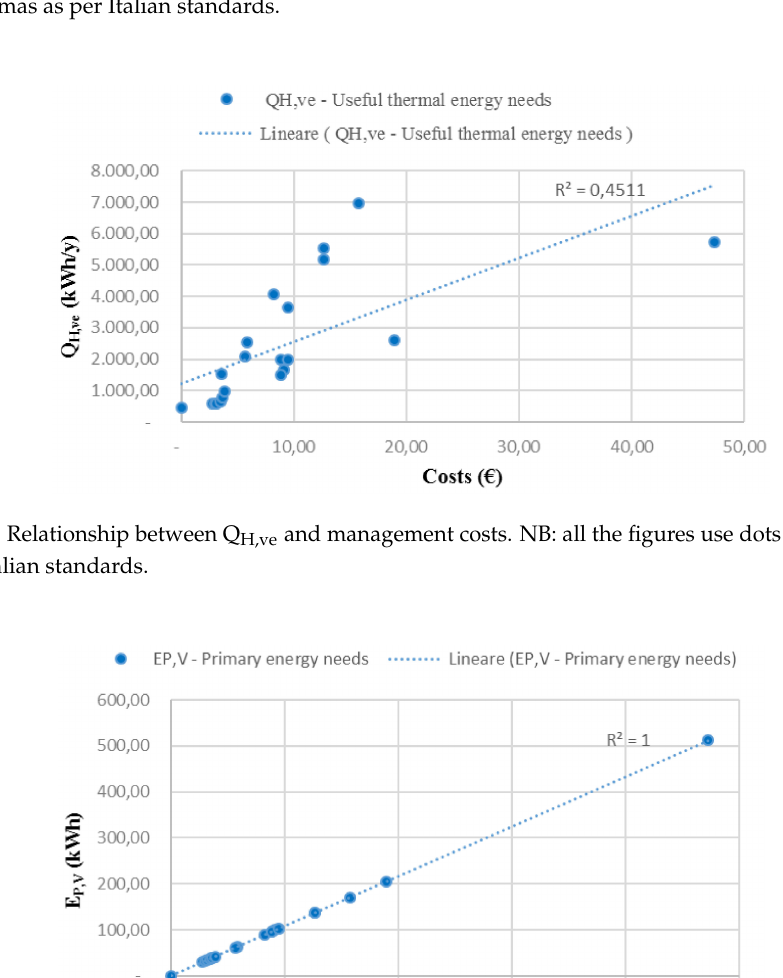
Figure 5. Relationship between Q H,ve , E P,V and minimum air flow of fan. NB: all the figures use dots and commas as per Italian standards.